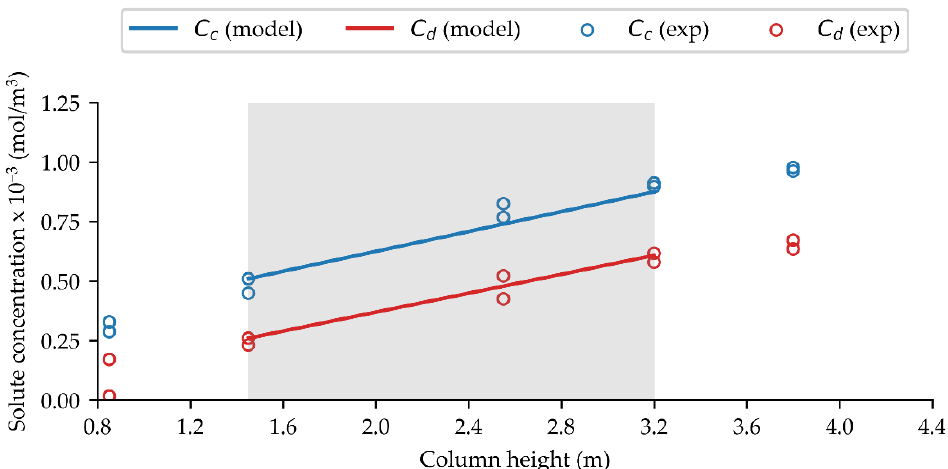
Figure 5. Experimental and modelled profiles of the RDC solute concentration in the organic and aqueous phase—the grey area indicates the portion of the column covered by the CSTR in the series model.